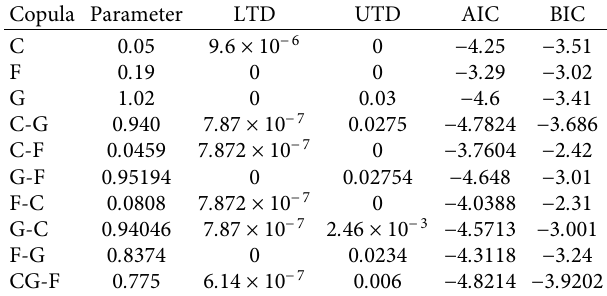
Table 5: Parameter estimates with LTD, UTD, AIC, and BIC. Copula